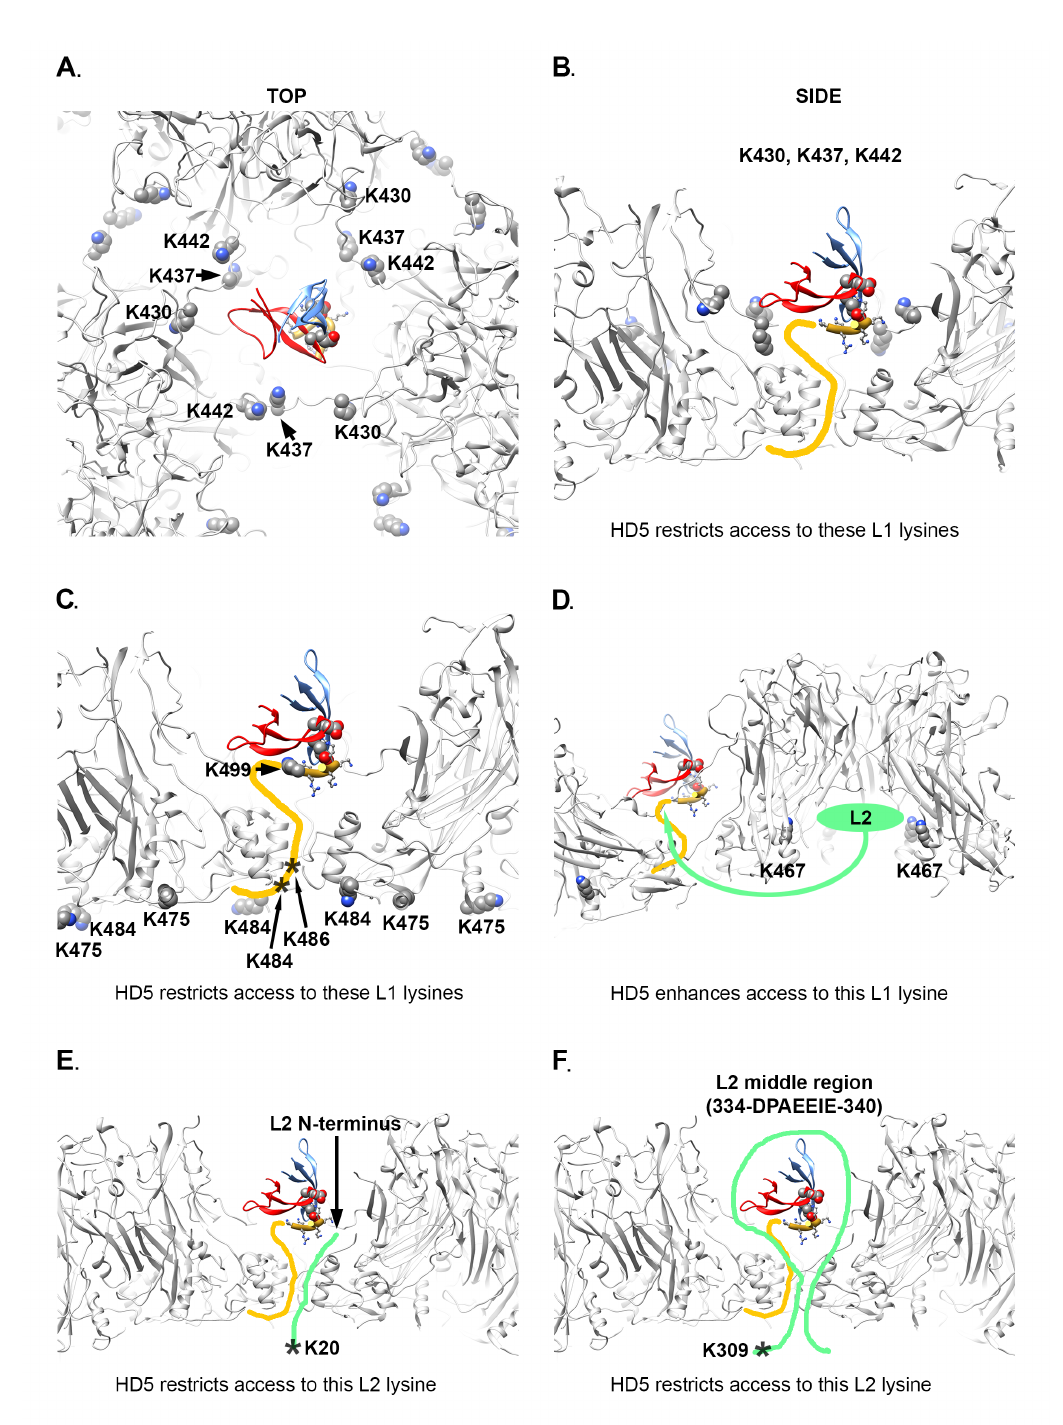
Figure 6. Structural models illustrating effect of HD5 on acetylation of L1 and L2 lysine residues. (A,B) Top and side views of the L1 capsid (gray) with the MD-derived model of an HD5 dimer and the last 6 residues of the L1 C-terminal tail (aa 499-505, gold ribbon) as in Figure 4D. Note that the MD-de- rived model is in a different orientation with respect to the HPV capsid compared to Figure 5. L1 residues K430, K437 and K442 (space-filling) from 3 L1 subunits surround the HD5 dimer in a capsid